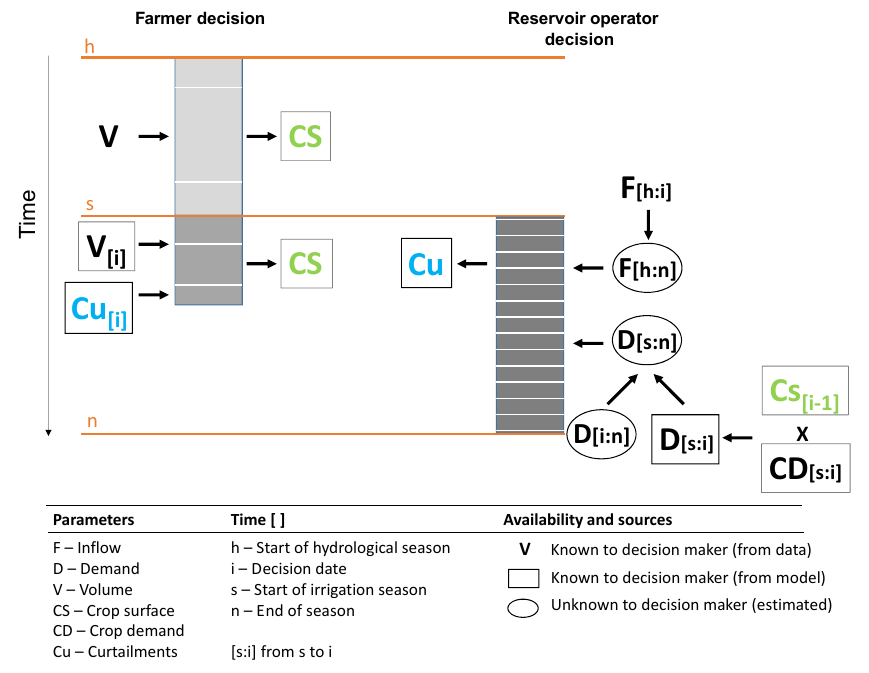
Figure 4. Model decisions, parameters that inform them and decision outputs. A description of the abbreviations is included below. The period considered for each parameter is given in between square brackets. The shapes indicate the availability and source of the information. The parameters representing the information that is exchanged between the two decision models are coloured in green (crop surface, CS) and blue (curtailments, Cu). The grey boxes represent different blocks of the decision models. The reservoir operation decision has the same kind of input and output for each decision date, while the farmer’s decision has different inputs before and after the start of the irrigation season. The white lines within the blocks represent the moments at which decisions are made (time i